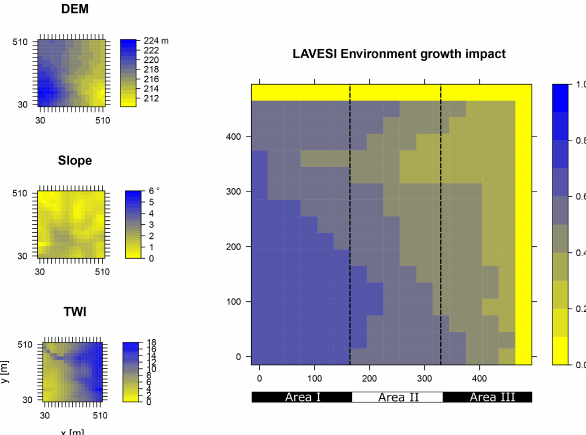
Figure B3. Elevation (DEM), slope angle, and terrain water index (TWI) define the environment growth impact (0 no growth possible; 1 good, no constraints) using an empirically fitted function for present forest growth at the area of interest Spasskaya Pad.